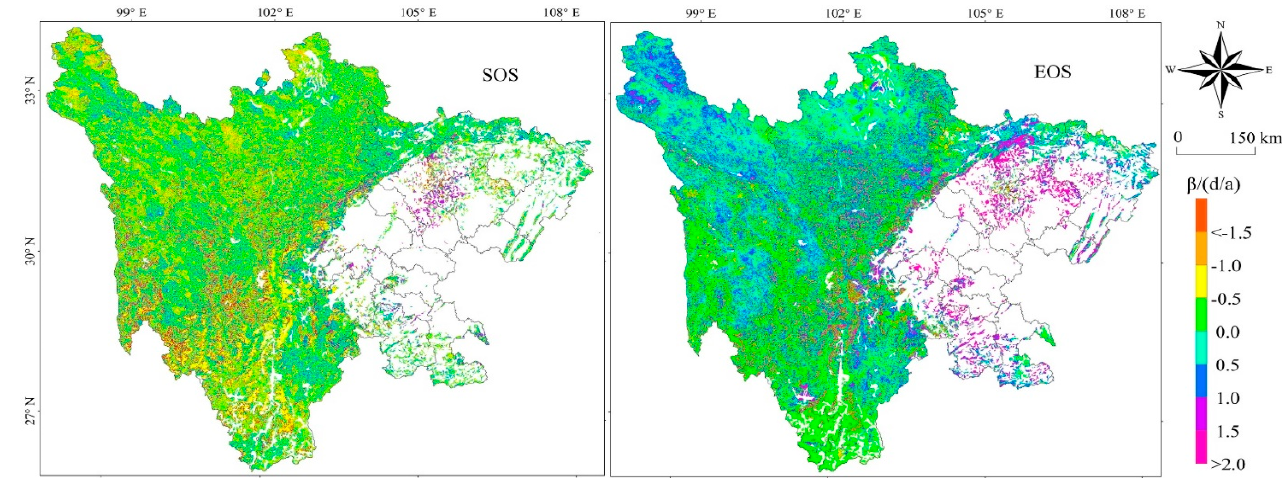
Figure 5. Analysis of the phenological sustainability of grasslands in Sichuan Province using the Hurst exponent ( β (d/a).